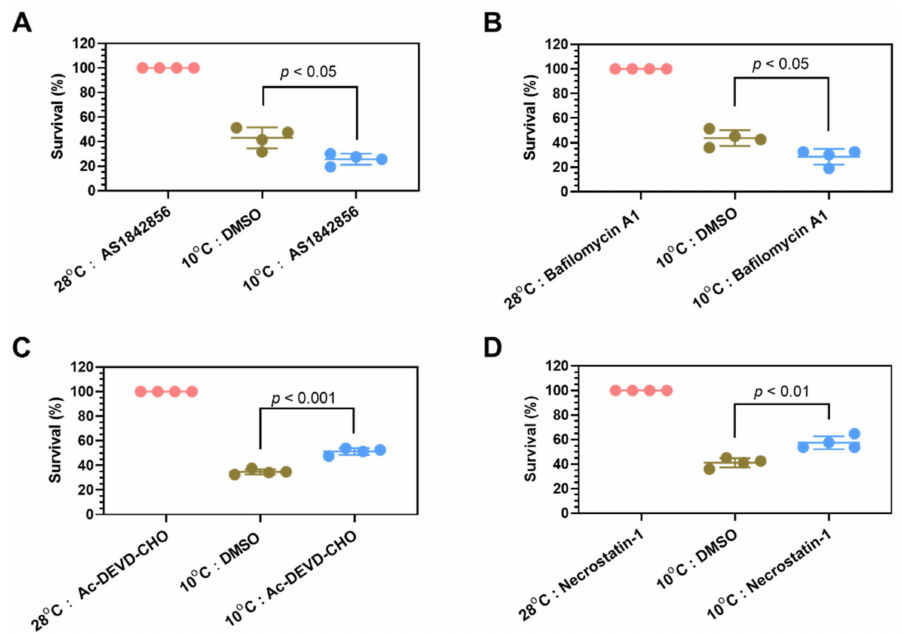
Figure 7. Effects of inhibiting Foxo1, autophagy, apoptosis and necroptosis on cold resistance of zebrafish larvae. ( A , B ) Treatment with AS1842856 (0.5 µ M), an inhibitor of Foxo1 ( A ) and Bafilomycin A1 (50 nm), an inhibitor of autophagy ( B ), sensitized zebrafish larvae to cold stress. ( C , D ) Treatment with Ac-DEVD-CHO (5 µ M), an inhibitor of Group II caspases ( C ) and Necrostatin-1 (50 µ M), a specific RIP1 (RIPK1) inhibitor and inhibits TNF- α -induced necroptosis ( D ) increased survival of zebrafish larvae exposed to lethal cold